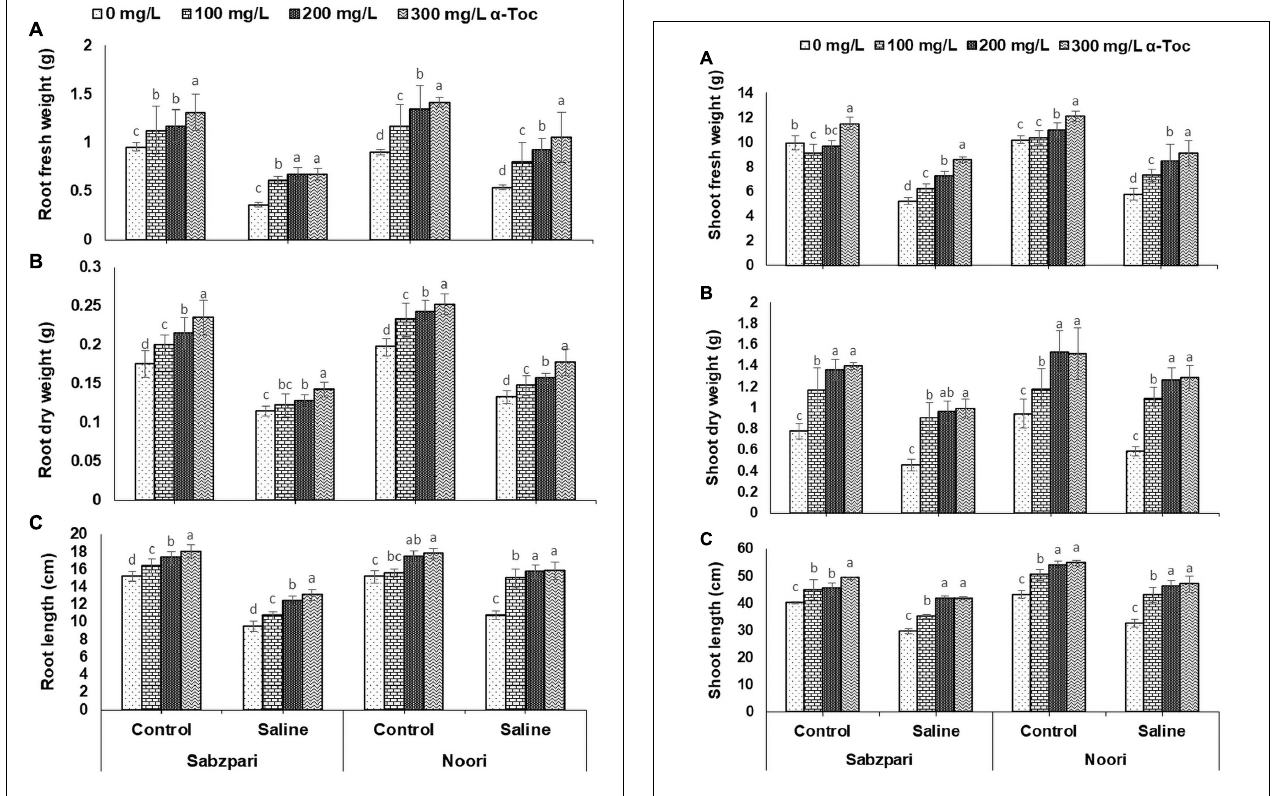
FIGURE 2 | Shoot fresh weight (A) , Shoot dry weight (B) and Shoot length (C) of okra varieties sprayed with different levels of α -tocopherol under saline conditions. Values represent means ± S.D. Significant differences among row spacing were measured by the least significant difference (LSD) at p > 0.05 and indicated by different